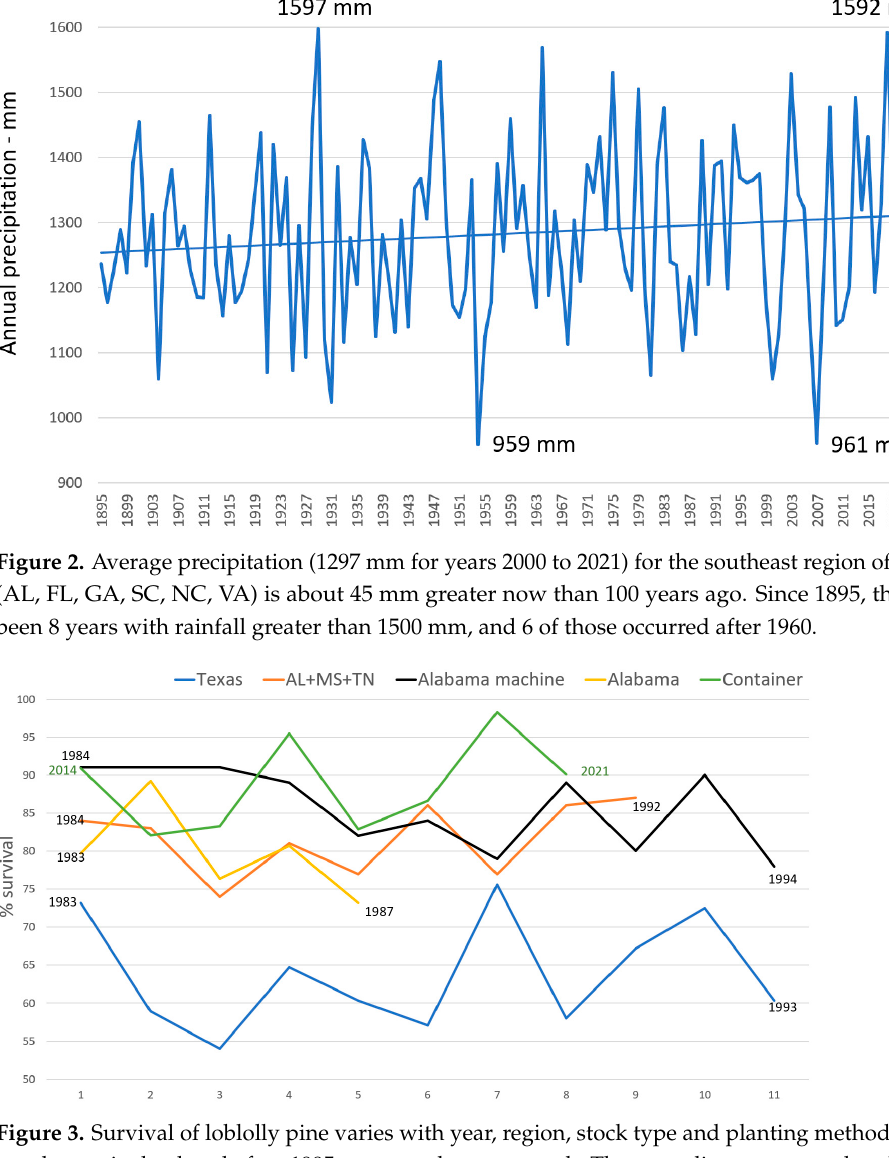
Figure 3. Survival of loblolly pine varies with year, region, stock type and planting method. For this graph, survival values before 1995 represent bareroot stock. The green line represents hand-planted container-grown stock, and the black line represents machine-planted bareroot stock. The average rainfall for East Texas (1176 mm) is about 17% less than the average rainfall for North Alabama (1418 mm). Data were provided by Brad Barber (Texas), Steve McKeand (container), Jerry Frame (Alabama machine; AL + MS + TN) and Harry Vanderveer